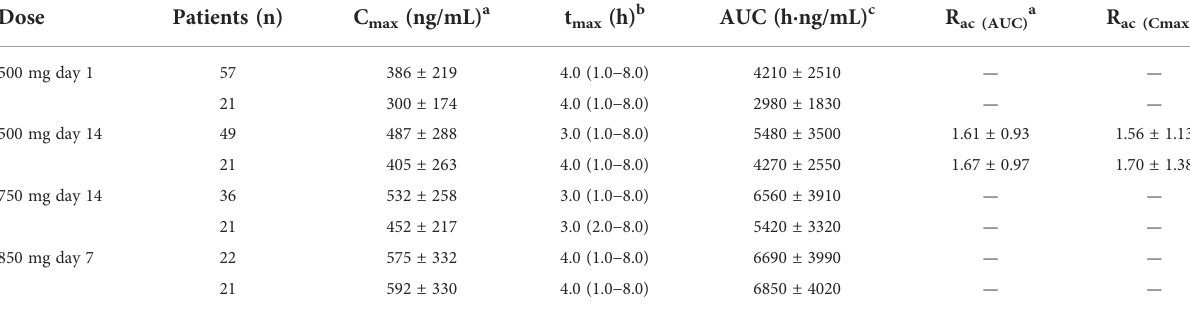
TABLE 2 Pharmacokinetic parameters of apatinib in patient population assessable at each sampling day and in the 21 patients completed plasma sampling over all dose range.